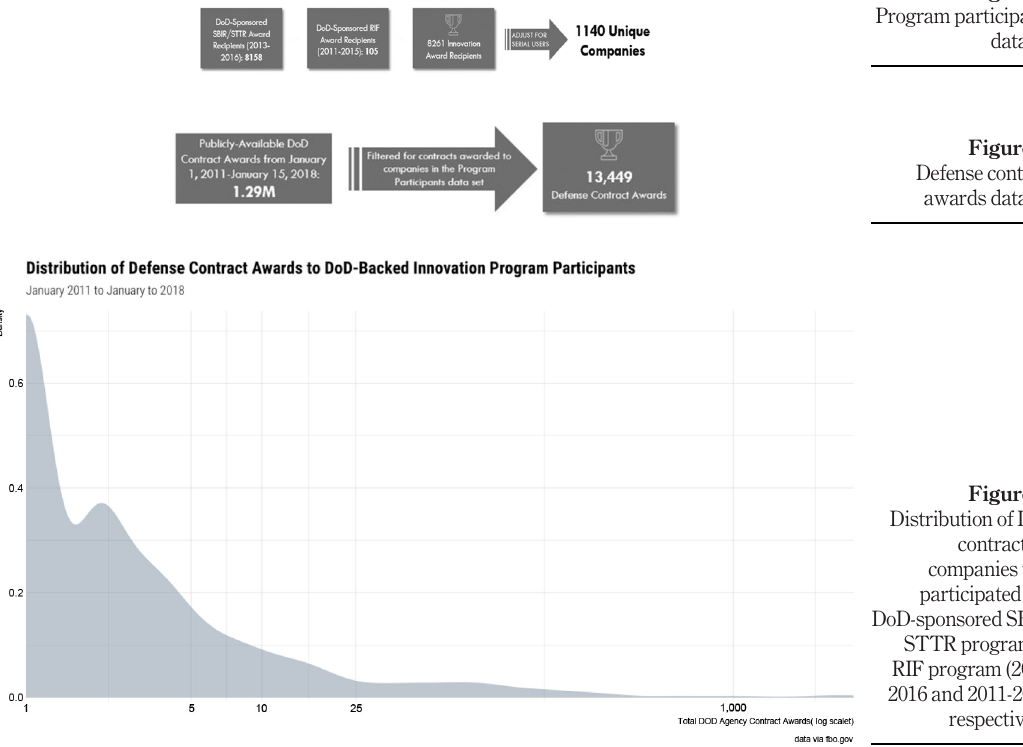
Figure 2. Program participants